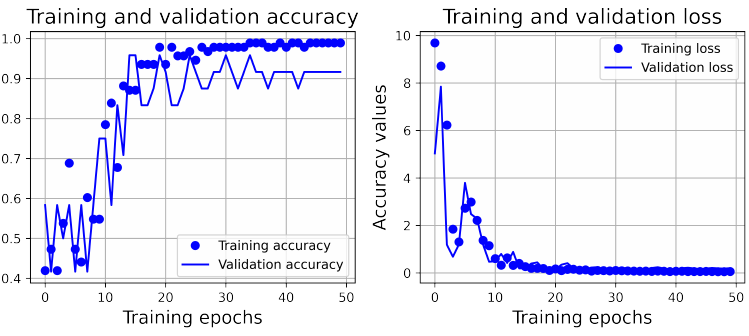
Figure 6. Charts of objects classification accuracy and the loss function value during the network training on the data in the first cluster.